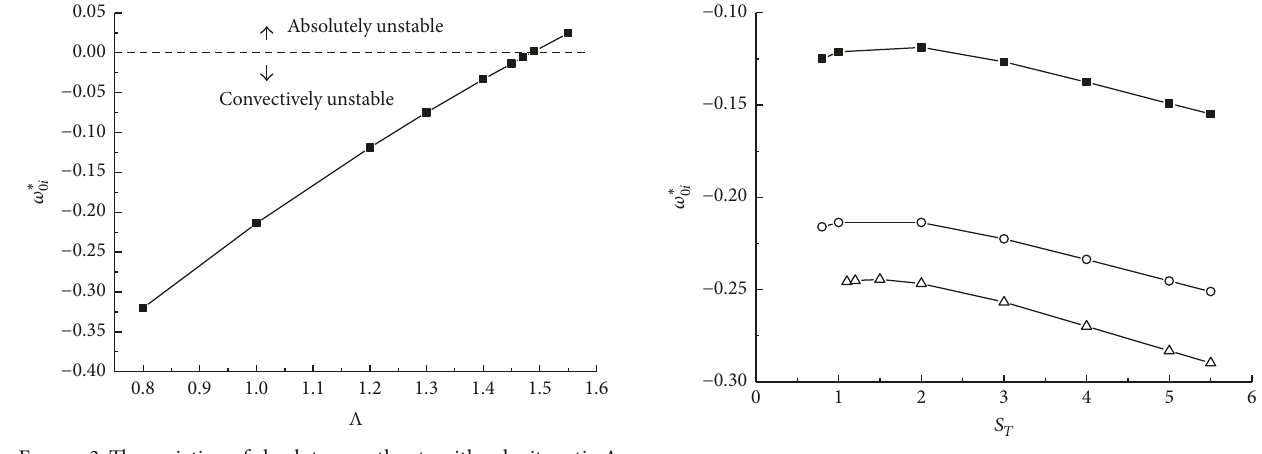
Figure 3: The variation of absolute growth rate with velocity ratio Λ ( 𝜙 = 0 , 𝑀 = 0 , 𝑆 𝑇 = 3 ).